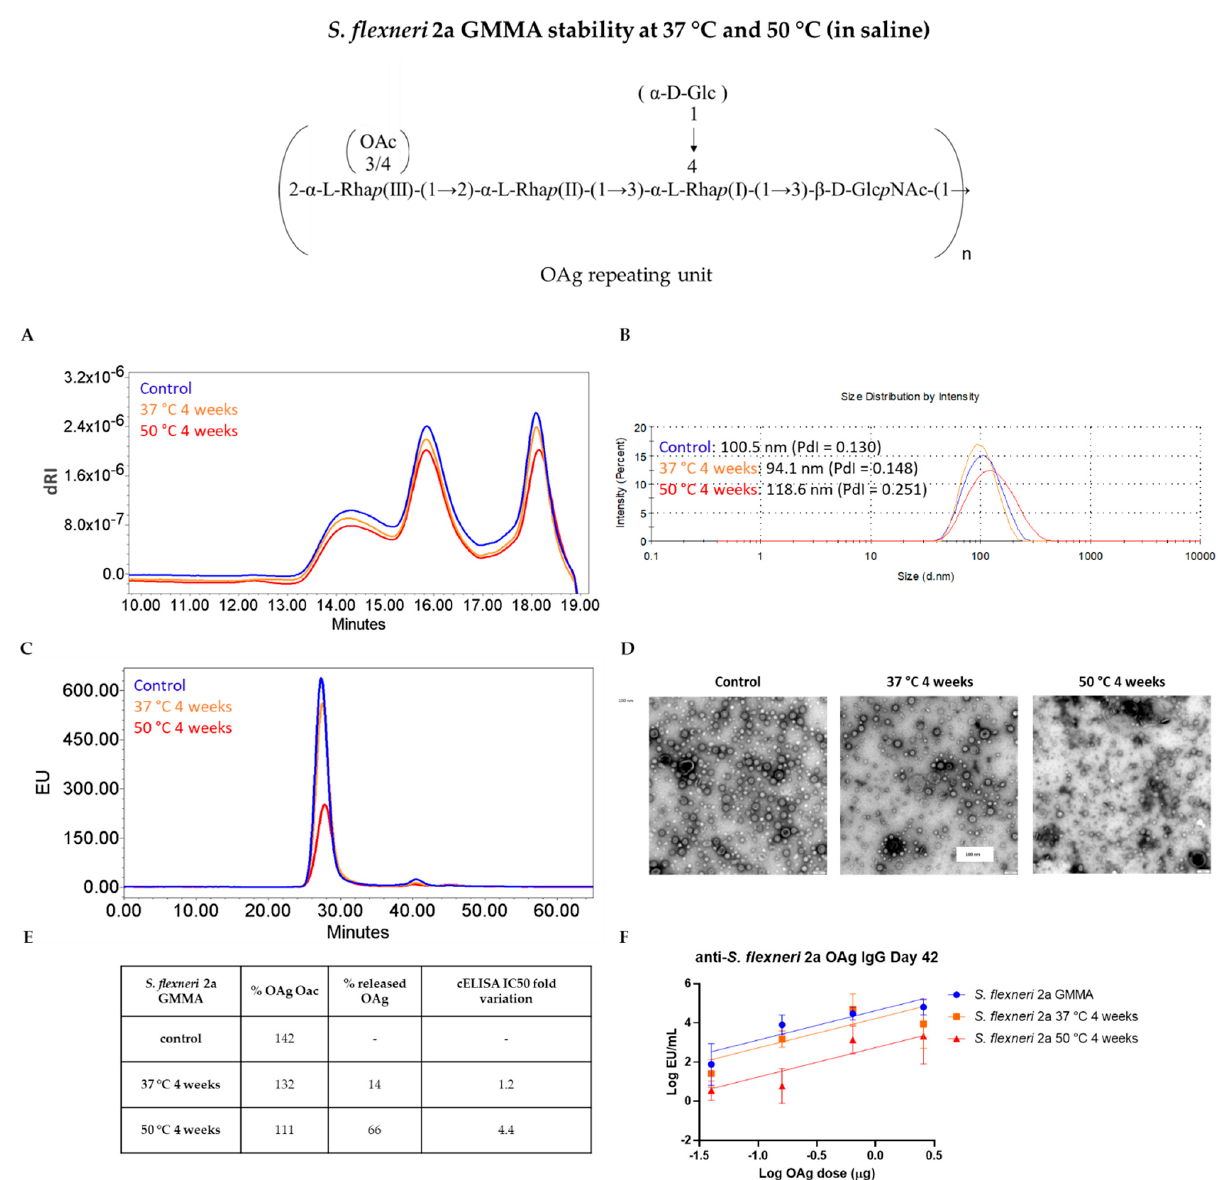
Figure 4. Characterization of S. flexneri 2a GMMA stressed for 4 weeks at 37 °C and 50 °C: ( A ) HPLC-SEC analysis of extracted OAg from GMMA samples; ( B ) DLS, ( C ) HPLC-SEC and ( D ) TEM analyses performed on GMMA: disruption and aggregation of GMMA vesicles start after one month at 37 °C with a worsening trend visible at the higher temperature of 50 °C (scale bar = 100 nm). ( E ) Summary table with OAg O-acetylation level, percentage of OAg detached from GMMA membrane and cELISA IC50 fold variation. ( F ) Stressed GMMA were tested in mice: animals were immunized at day 0 and 28 and anti-OAg IgG response determined by ELISA at day 42 in single sera from each group. the graph reports parallel lines (log transformed ELISA units vs. log transformed μ g OAg dose) where Y-intercepts of the dose–response curves are compared ( p -value = 0.0074).